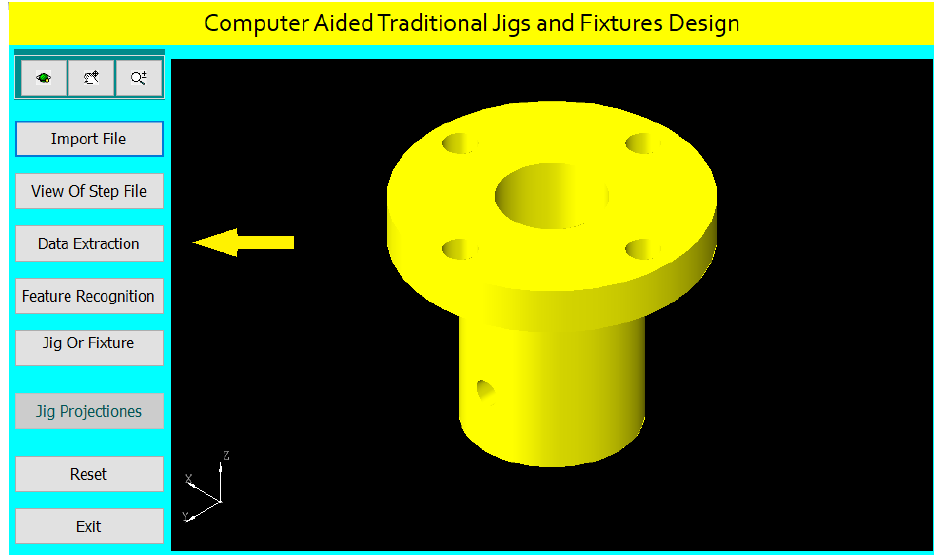
Figure 11. The third screen of the system interface.